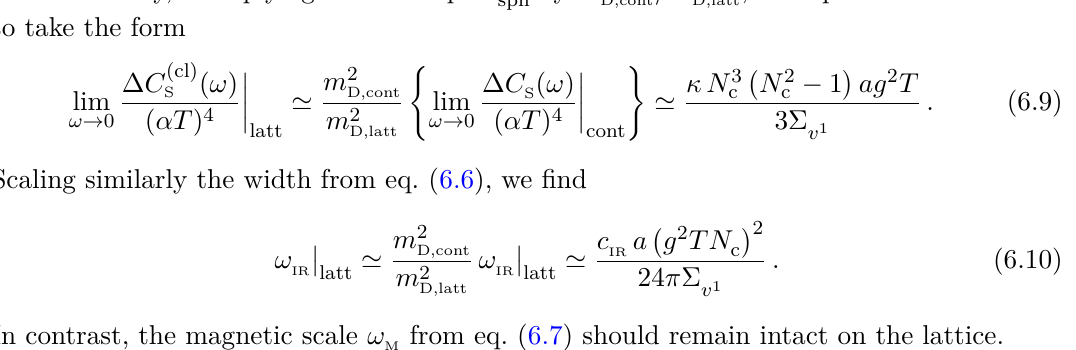
The coefficient here has the numerical value Σ ≈ 2 . 1498783949 , where we adopted the v 1 more general notation of ref. [38]. Therefore, continuum estimates can be converted into lattice estimates, by rescaling them with appropriate powers of the Debye mass squared